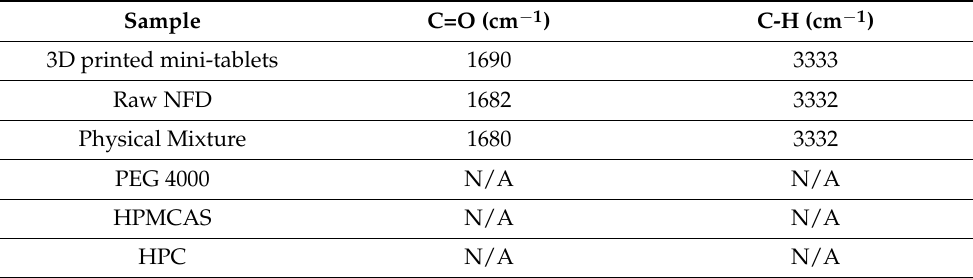
Table 2. FTIR spectra of the 3D printed minitablets, the raw NFD, and the physical mixture. Bands that showed a characteristic shift are illustrated in the